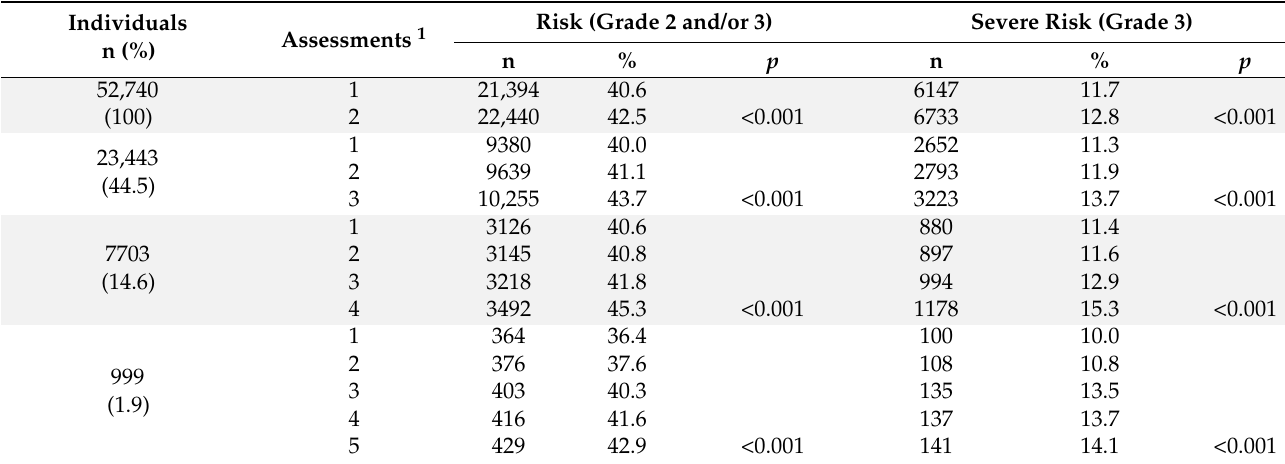
Table 5. Number of individuals in nursing homes who received two to five annual ROAG-J assessments (2011–2016) and change in ROAG-J risk, shown as number of individuals and percentage annually with risk and severe risk, respectively. p -values for risk–no risk between the first assessment and the last assessment with Fisher’s exact